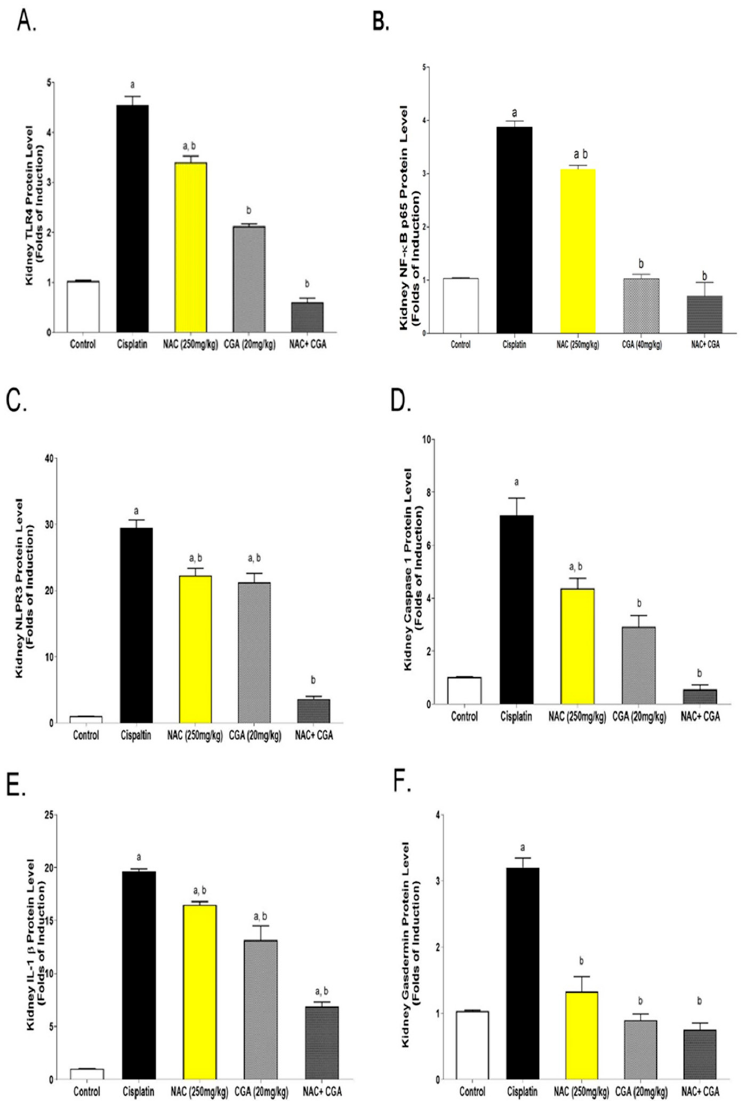
Figure 4. Quantitative Results of Immunoblots of TLR4/NF-kB/NLPR3/IL-1 β and Caspase1/GSDMD Signaling Pathway in Kidney Tissue of Rats. Densities were quantified using analysis software. ( A – F ) Quantitative results of the immunoblot of TLR4, NF- κ B, NLPR3, caspase-1, IL-1 β , and GSDMD. Protein levels are expressed as the ratio of protein/GAPDH. The relative quantities were normalized to the control and expressed as a fold of induction. Data are presented as the mean ± SEM (n = 3). a p ≤ 0.05 compared to the control group; b p ≤ 0.05 compared to the cisplatin group. p ≤ 0.05 using ANOVA followed by Tukey-Kramer as post-hoc test. Control: normal rats; Cis: Cisplatin-injected (7 mg/kg, i.p.) rats; Cis + NAC: Cisplatin-injected rats treated with NAC (250 mg/kg/day, p.o.) one week before and after cisplatin injection; Cis + CGA: Cisplatin-injected rats treated with CGA (20 mg/kg/day, p.o.) one week before and after cisplatin injection; Cis + NAC + CGA: Cisplatin-injected rats treated with NAC (250 mg/kg/day, p.o.) and CGA (20 mg/kg/day, p.o.) one week before and after cisplatin injection. For TLR4 (F = 238.8, df = 4, p < 0.0001), for NF-kB (F = 226, df = 4, p < 0.0001), for NLPR3 (F = 144, df = 4, p < 0.0001), for caspase-1 (F = 41, df = 4, p < 0.0001), for IL-1 β (F = 125.3, df = 4, p < 0.0001), and for GSDMD (F = 50, df = 4, p < 0.0001). p values were evaluated using one-way ANOVA followed by Tukey–Kramer as a post-hoc test. NAC: N-acetylcysteine; CGA: Chlorogenic acid; TLR4: Toll-4 receptors; NF- κ B: Nuclear factor kappa B; NLPR3: Inflammasomes; IL-1 β : Interleukin-1 beta; GSDMD: Gasdermin